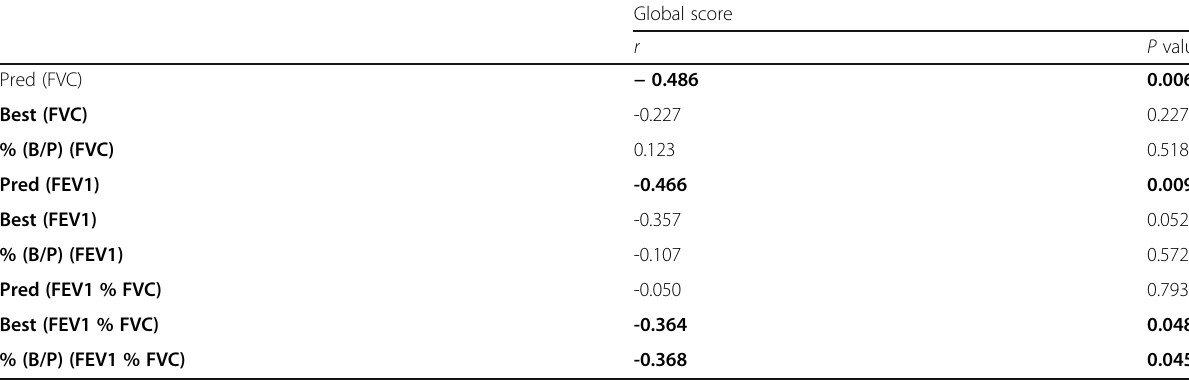
Table 10 Correlation of global score with pulmonary functions